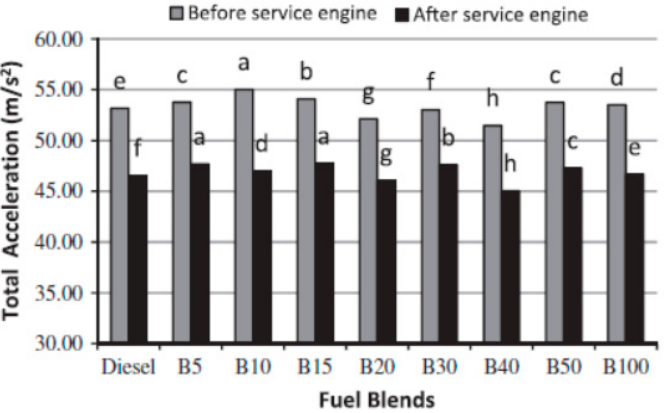
Figure 18. Total vibration acceleration ( a t ) of different diesel–biodiesel fuel blends, before and after the service engine [57]. Figure is reprinted with permission from the publisher.